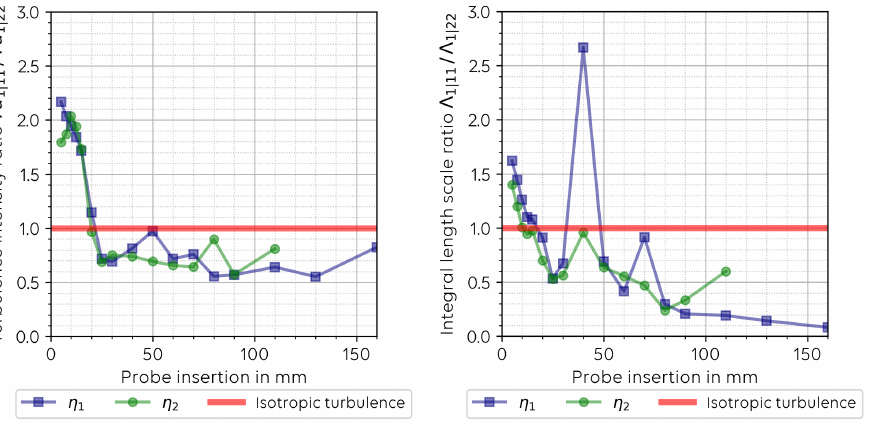
Figure 15. Turbulence isotropy analysis for two rotor speeds: η 1 ≈ 3800 RPM and η 2 ≈ 6840 RPM and several hot-wire probe radial positions. The thick red line shows the respective ratio for HIT. ( Left ) Turbulence intensity ratio of the longitudinal and transverse velocity component. ( Right ) Tur- bulence integral length scale ratio of the longitudinal and transverse velocity